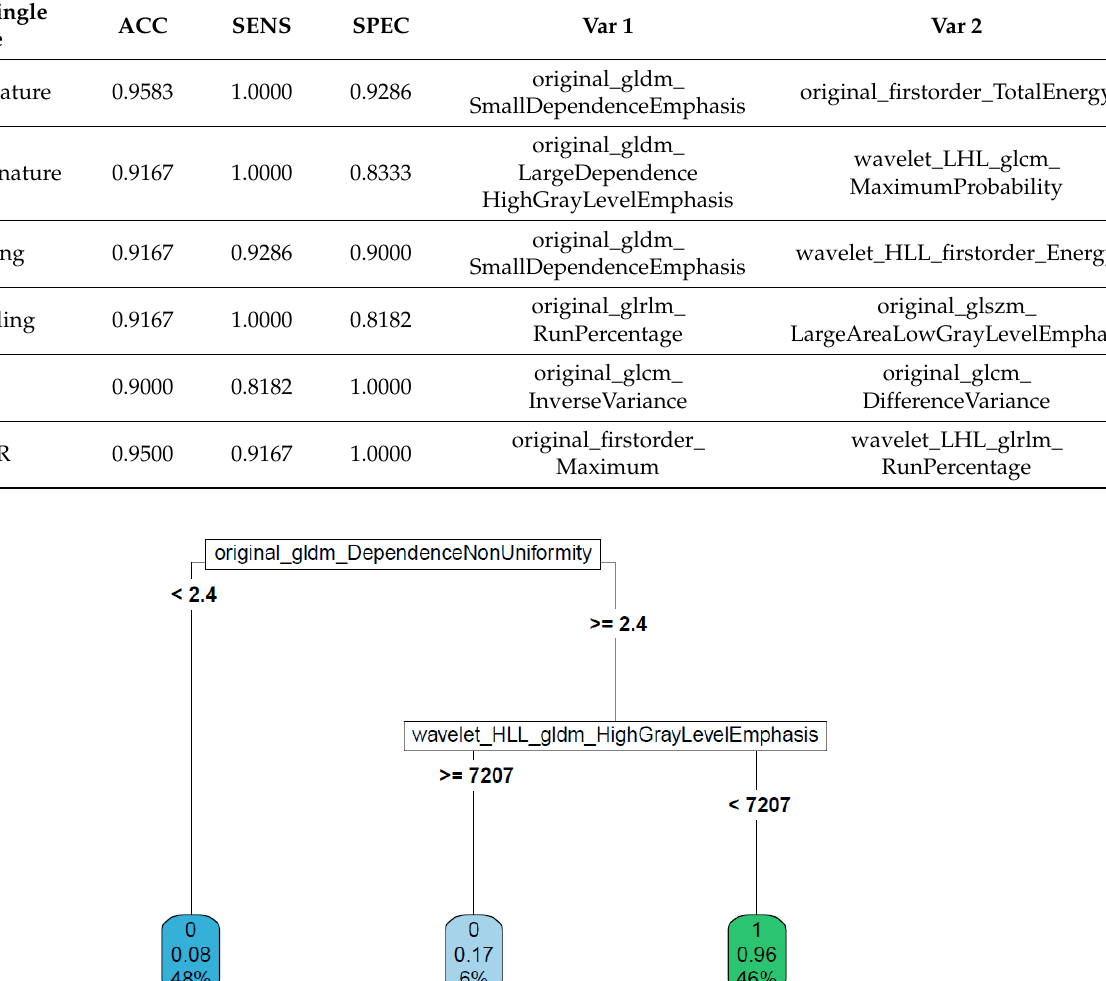
Table 5. Examples of results for logistic regression methods run using all possible combinations of two predictors.